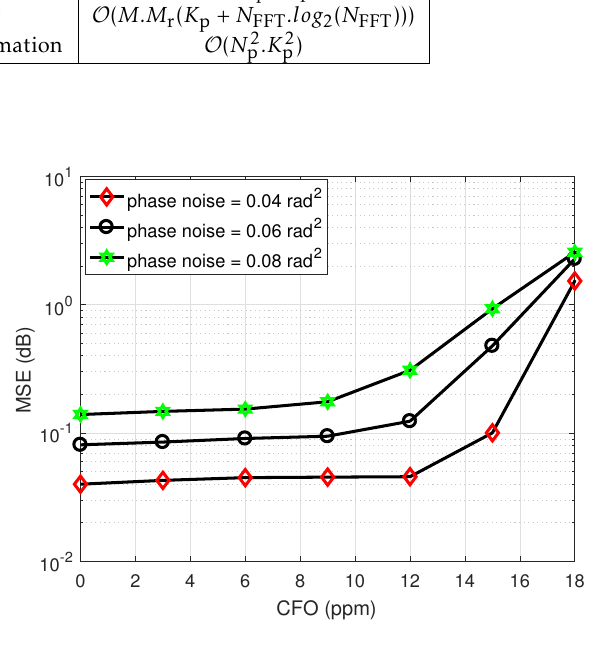
Figure 4. MSE as a function of CFO, 4 bit ADC.